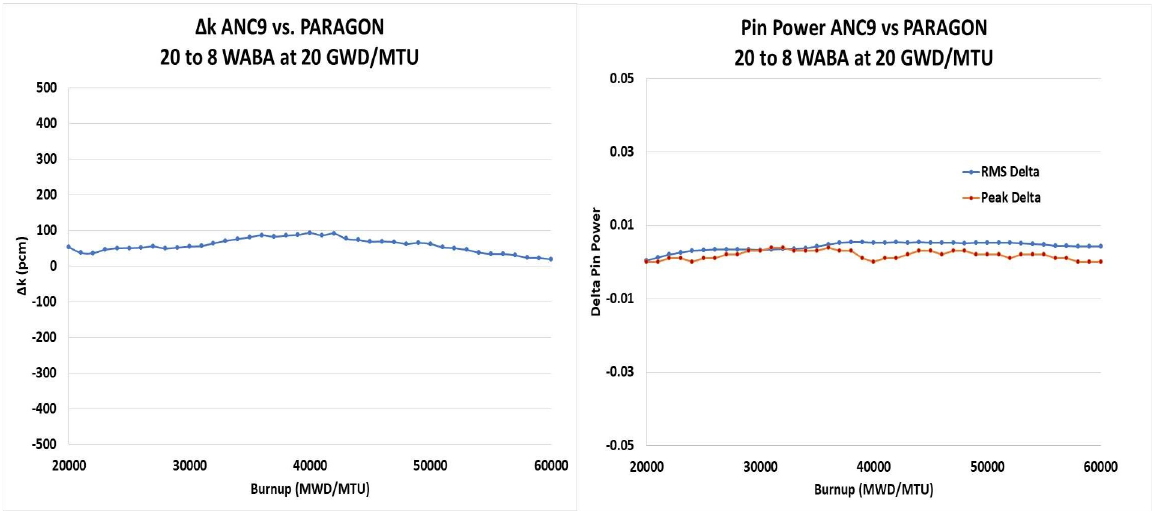
Figure 7. Comparison of eigenvalue and pin power for WABA replacement from 20 to 8 rods at 20